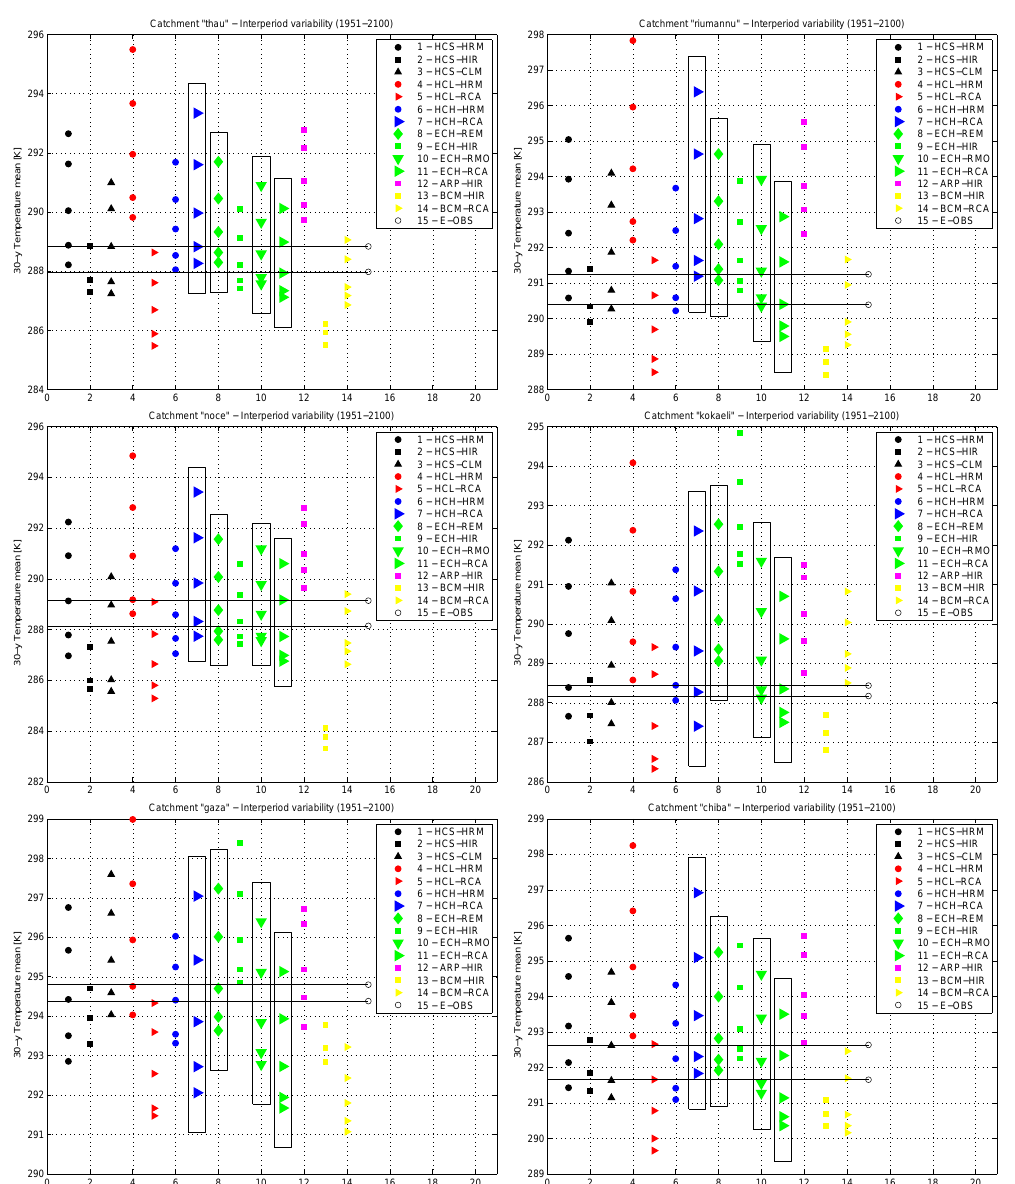
Fig. 10. Same as Fig. 9, but for temperatures (K) reduced to sea level.